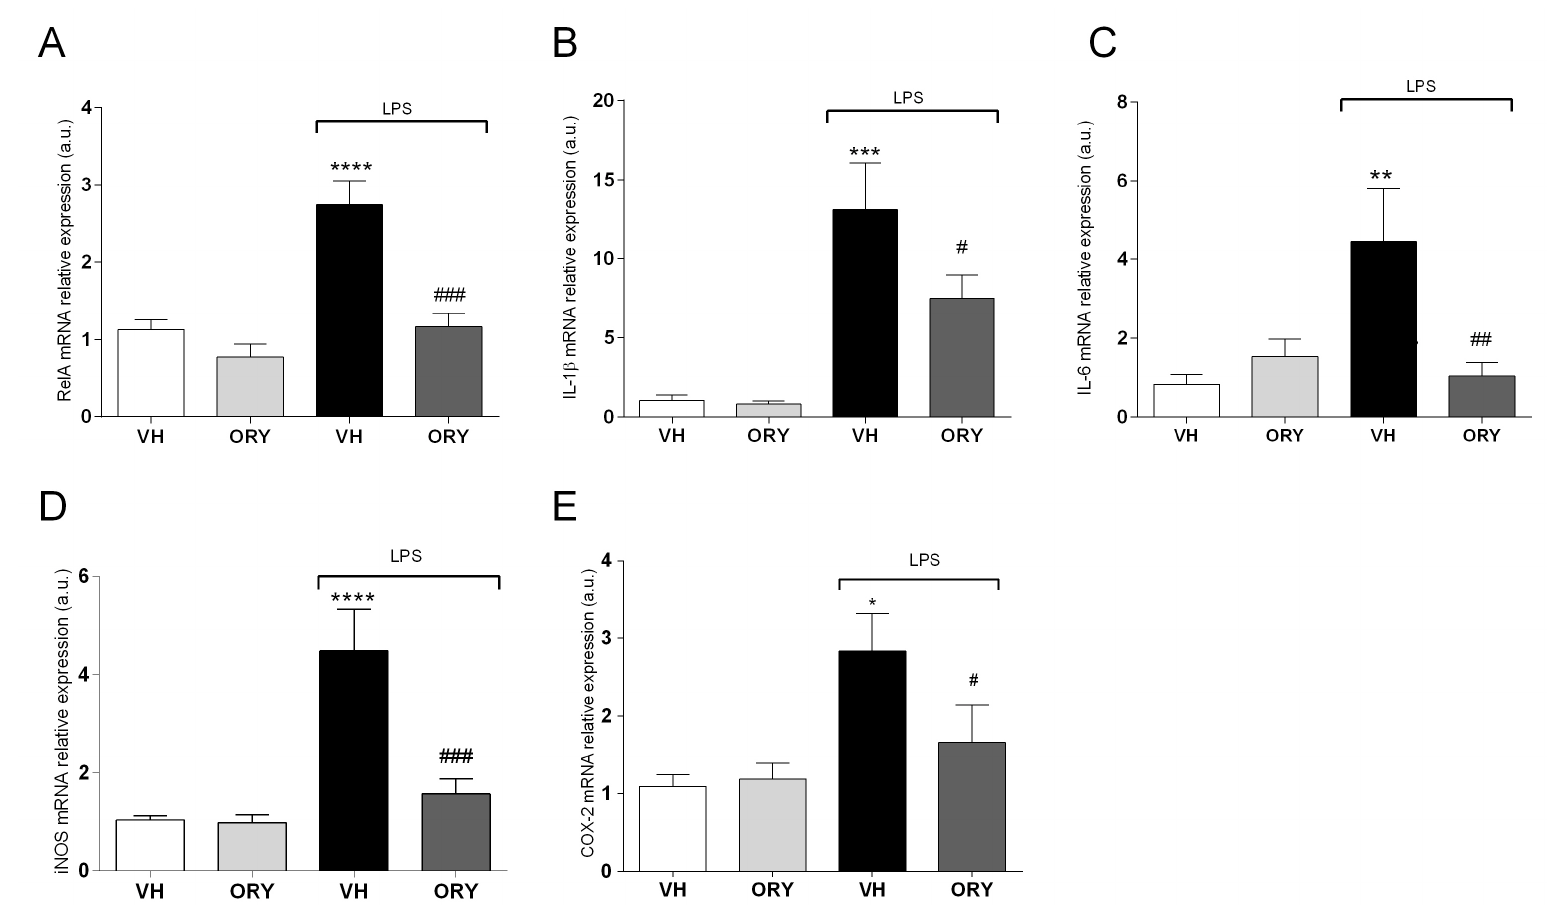
Figure 3. Graphic representation of quantitative RT-PCR data obtained from RNA extracted from the hippocampi of VH, ORY, LPS, and ORY+LPS mice. Data are expressed as the fold change of the target gene (RelA in ( A ), IL-1 β in ( B ), IL-6 in ( C ), iNOS in ( D ) and COX-2 in ( E )) normalized to the internal standard control gene ( β -Actin). Data are shown as the mean ± S.E.M. One-way ANOVA tests with Newman–Keuls post-test were used to determine statistical significance, * p < 0.05, ** p < 0.005, *** p < 0.0005 and **** p < 0.0001 vs. VH, # p < 0.05, ## p < 0.005 and ### p < 0.0005 vs. LPS. VH: vehicle; ORY: γ -oryzanol; LPS: